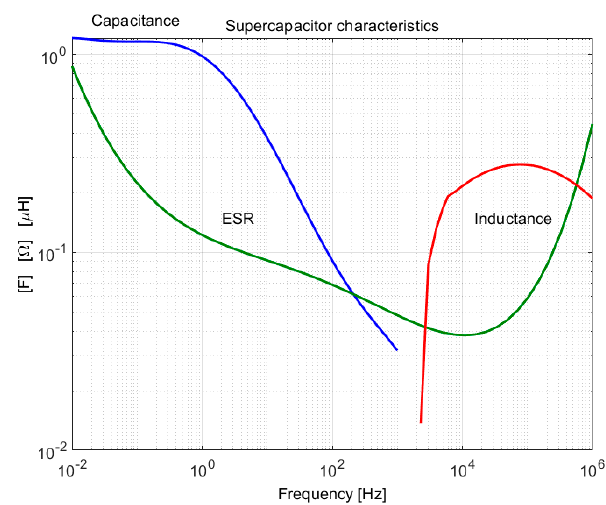
Figure 3. The frequency responses of series equivalent resistance (ESR), capacitance and inductance of CAP-XX HS-230 supercapacitor of 1.2 F nominal capacitance [23].